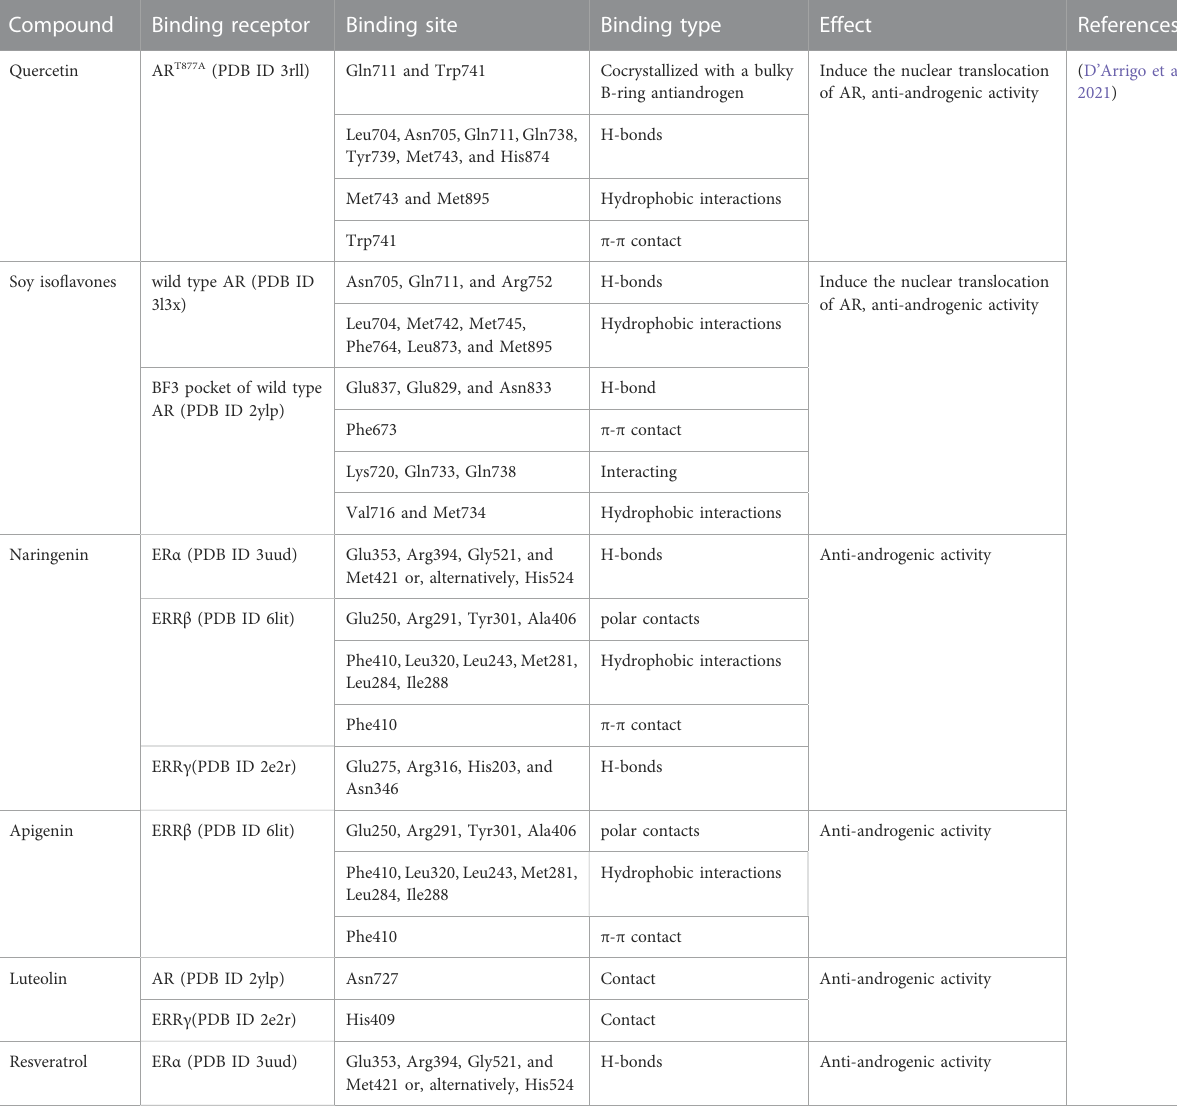
TABLE 4 Phytochemicals binding to androgen and estrogen